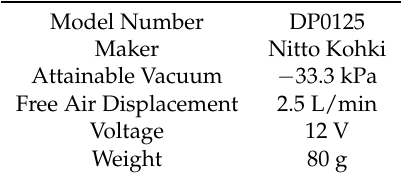
Table 2. Specification of the vacuum